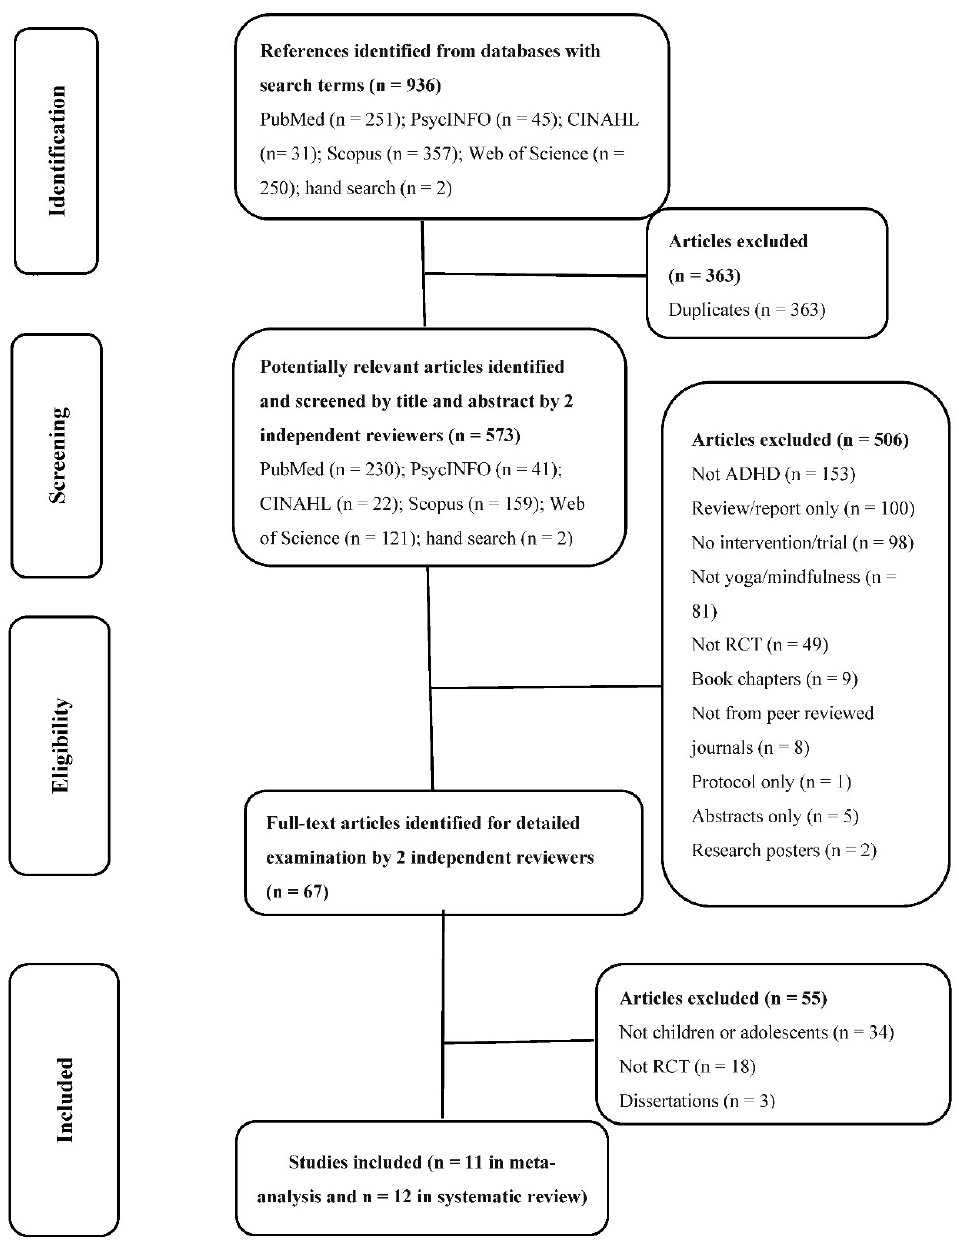
Figure 1. Flow diagram of the literature search.